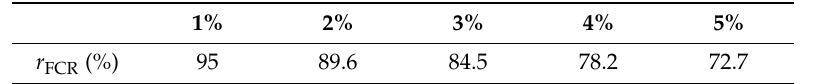
Table 4. Faults classification rate of the model corrected by optimization-based model